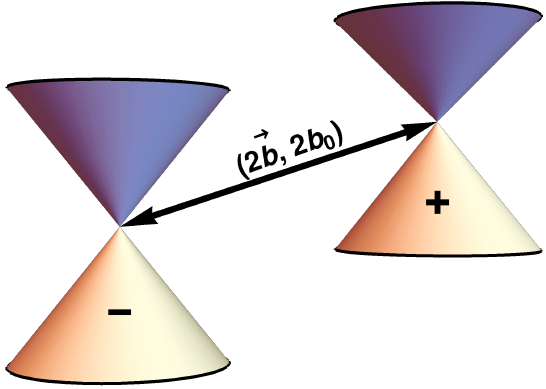
Figure 15: Dirac cones around Weyl points in a Weyl